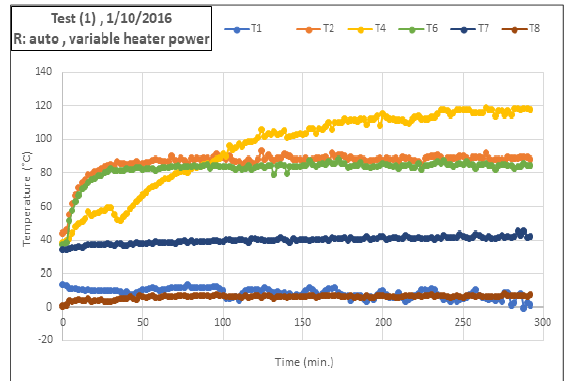
Fig. 9a. Refrigerant temperature with time for test